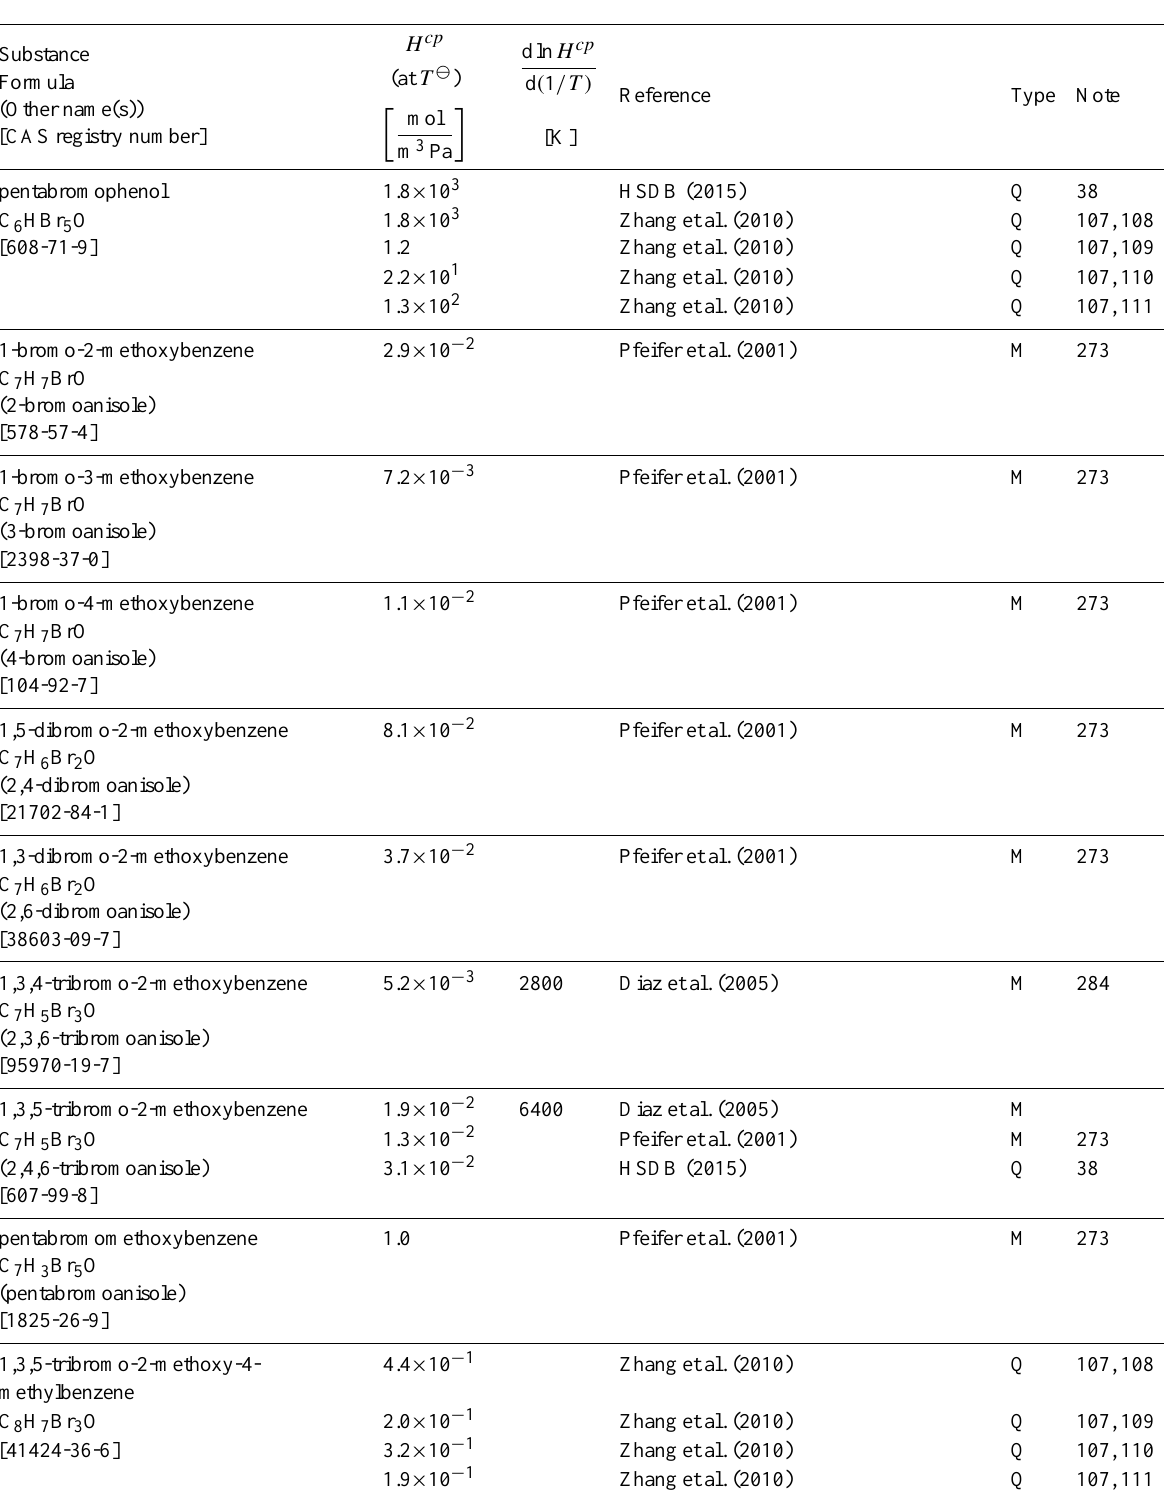
Table 6: Henry’s law constants for water as solvent